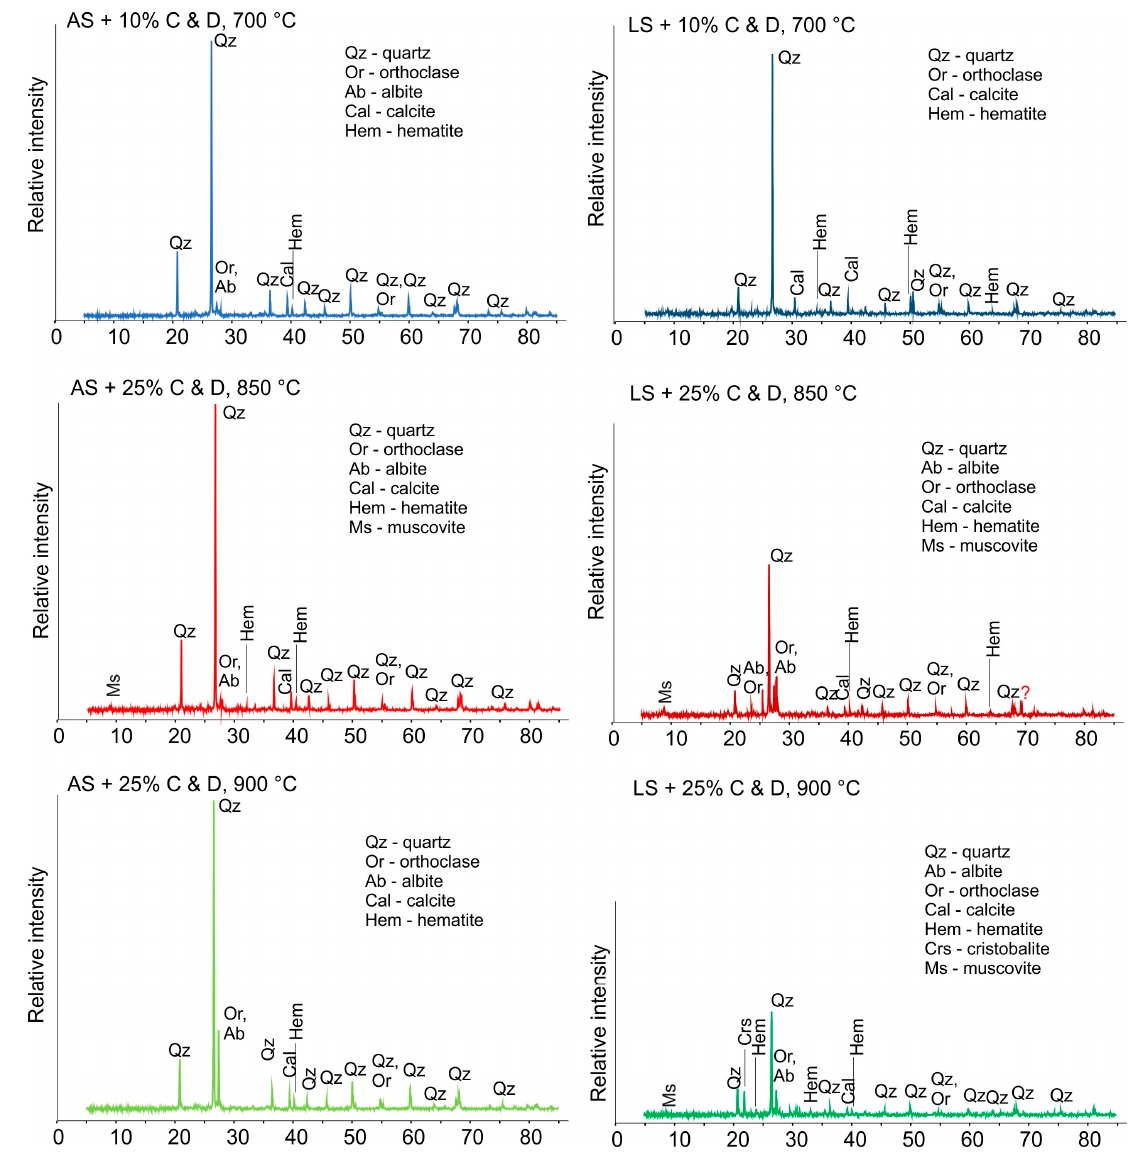
Figure 11. XRD analysis of the optimal mixtures.